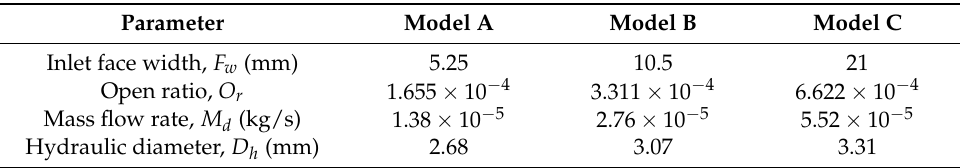
Table 3. Specification of each simulation